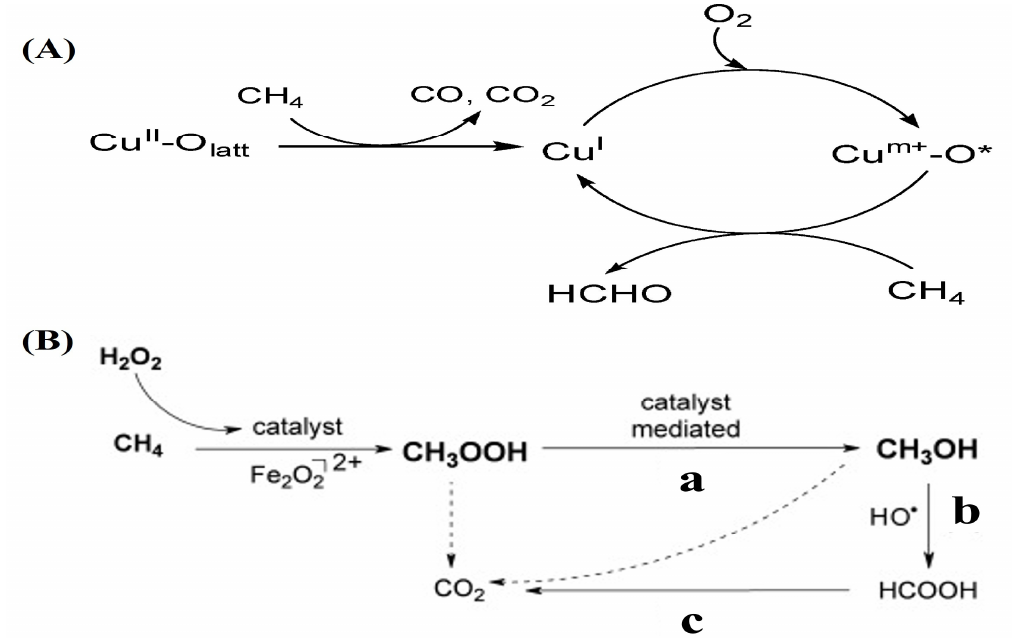
Figure 5. ( A ) Reaction mechanism for the selective oxidation of CH 4 to HCHO over the CuO x /SBA-15 catalyst. Reprinted/adapted with permission from Ref. [87]. Copyright 2008, copyright American Chemical Society, and ( B ) proposed reaction networks for the oxidation of methane over ZSM-5(30). Reprinted/adapted with permission from Ref. [111]. Copyright 2012, copyright Willy-VCH GmbH.